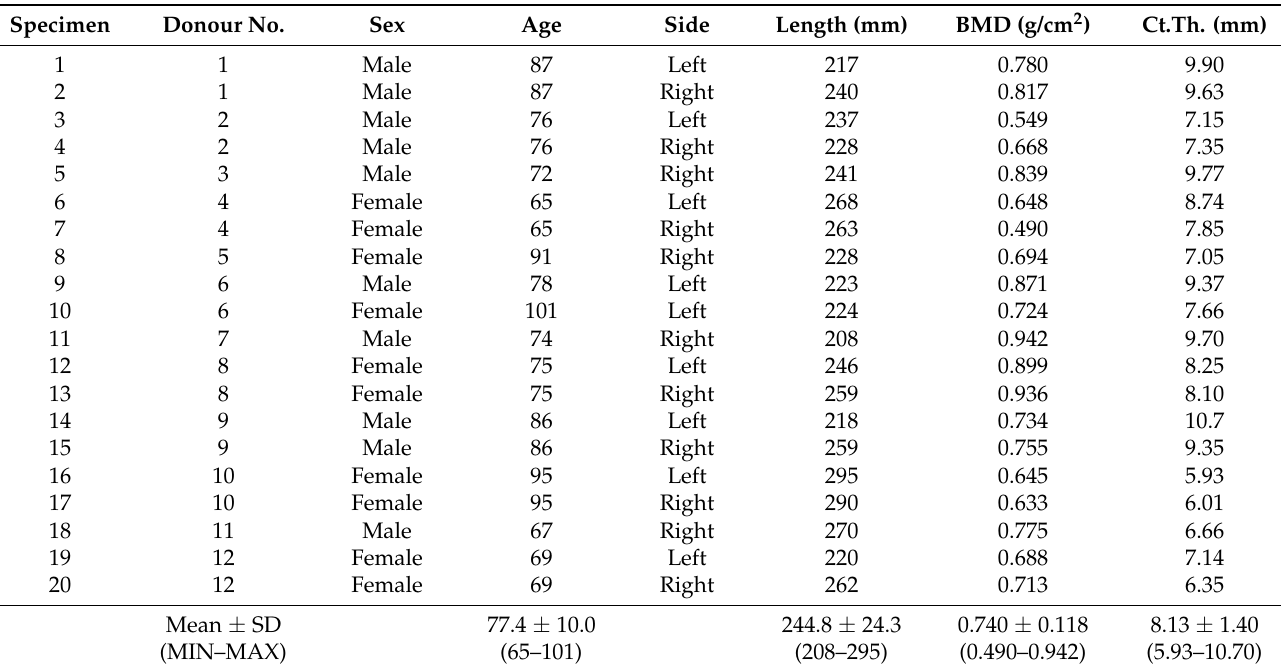
Table 1. Specimen data. Abbreviations: BMD (bone mineral density); Ct.Th. (cortical